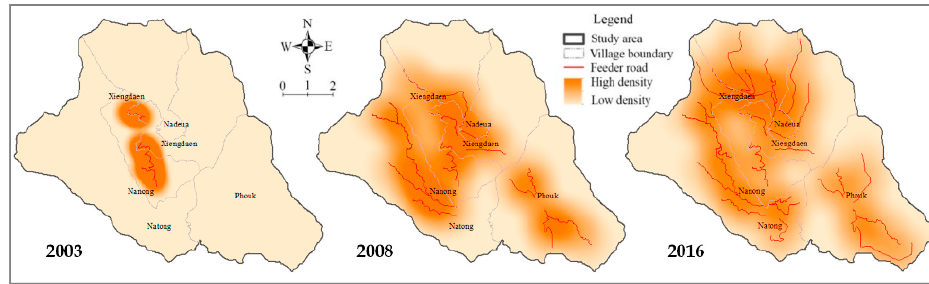
Figure 10. Feeder road expansion.